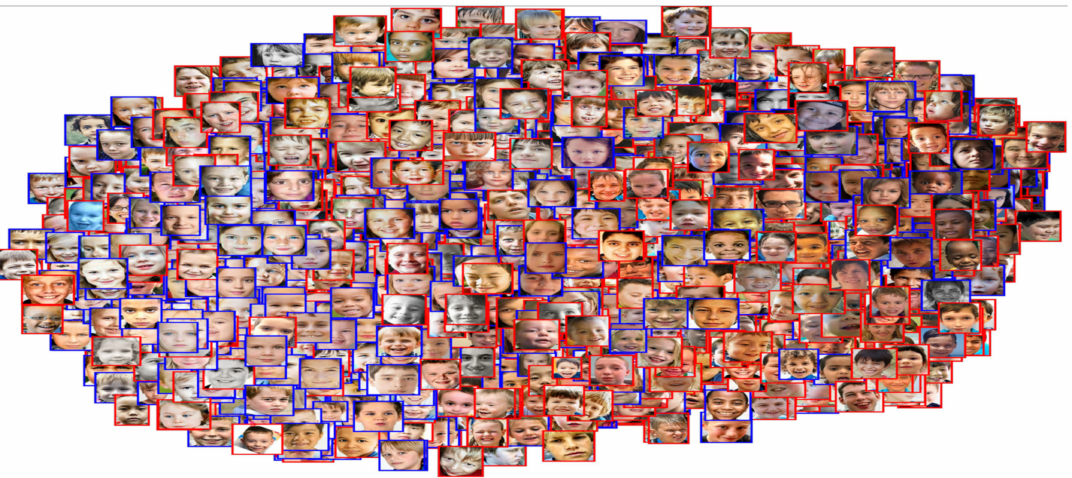
Figure 4. Images of autistic and non-autistic